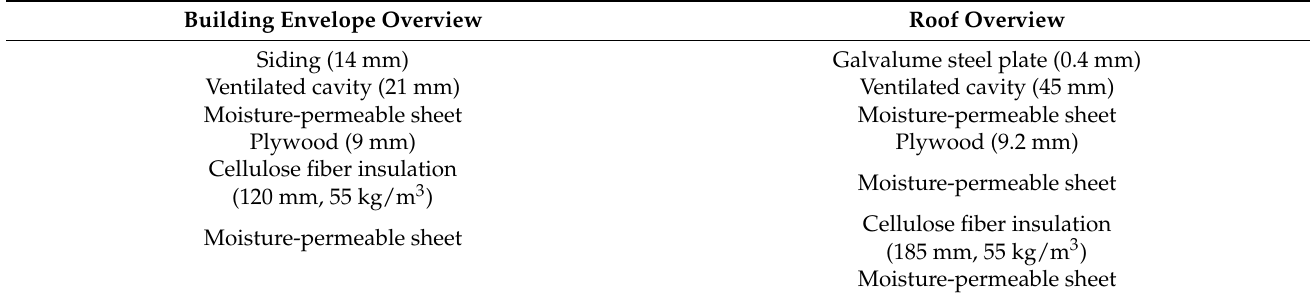
Table 3. Building envelope overview of the reviewed house (the top is the outdoor side; the bottom is the indoor side). Building Envelope